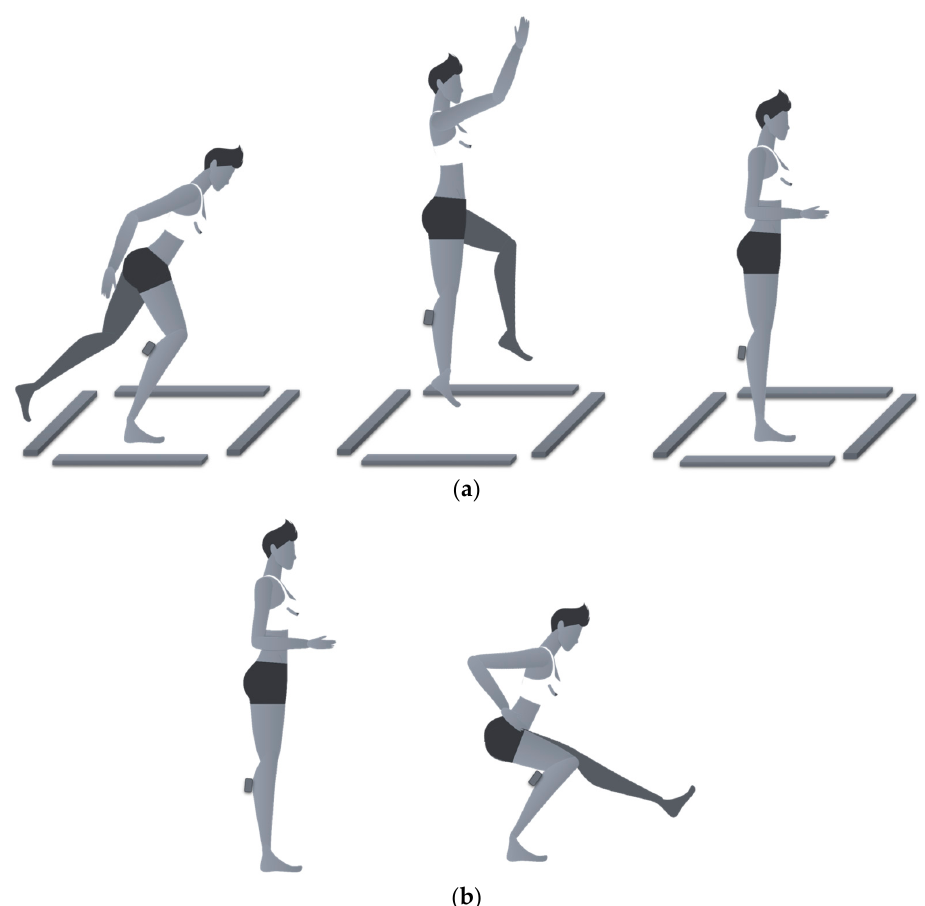
Figure 2 . ( a ) Movement sequence related to the monopodalic countermovement jump and ( b ) movement sequence related to the single-leg squat. The four grey bars on the floor represent the optoelectronic bars, and the gray box on the subject’s shank represents the IMU.